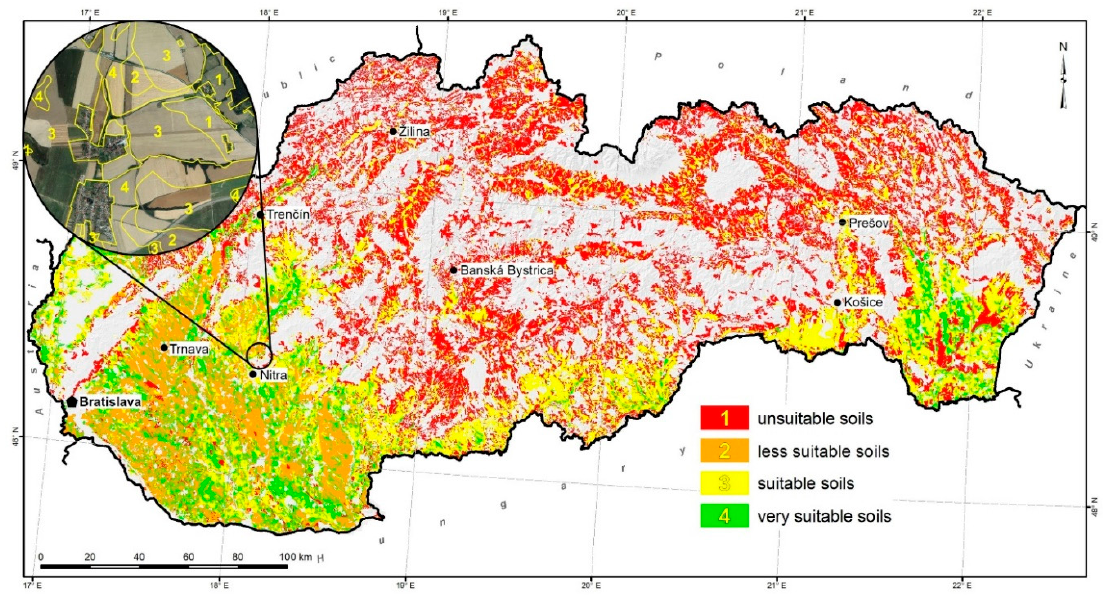
Figure 4. Suitability of agricultural soils in Slovakia for potato cultivation.